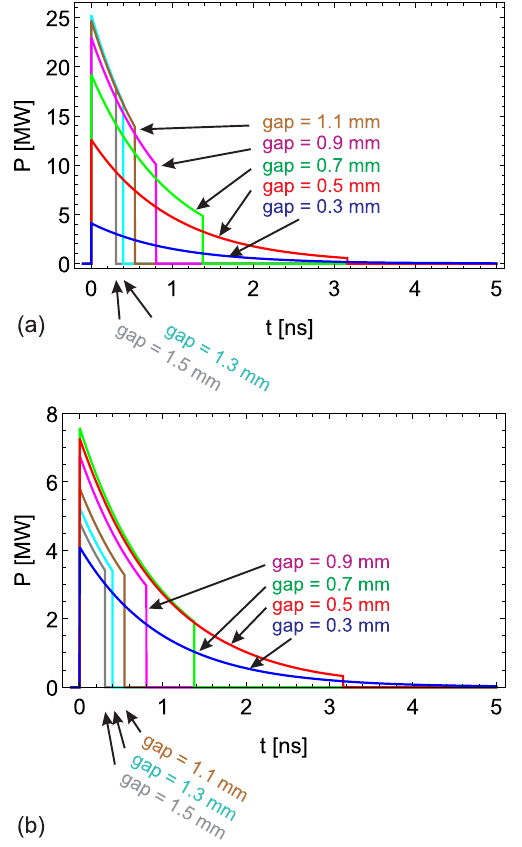
FIG. 4. Output rf power signals generated by a 3.2 nC bunch of 50 μ m, without coupler reflections (a) and taking into account the coupler reflection (b). The pulse rf durations depends on the group velocity, structure length, and